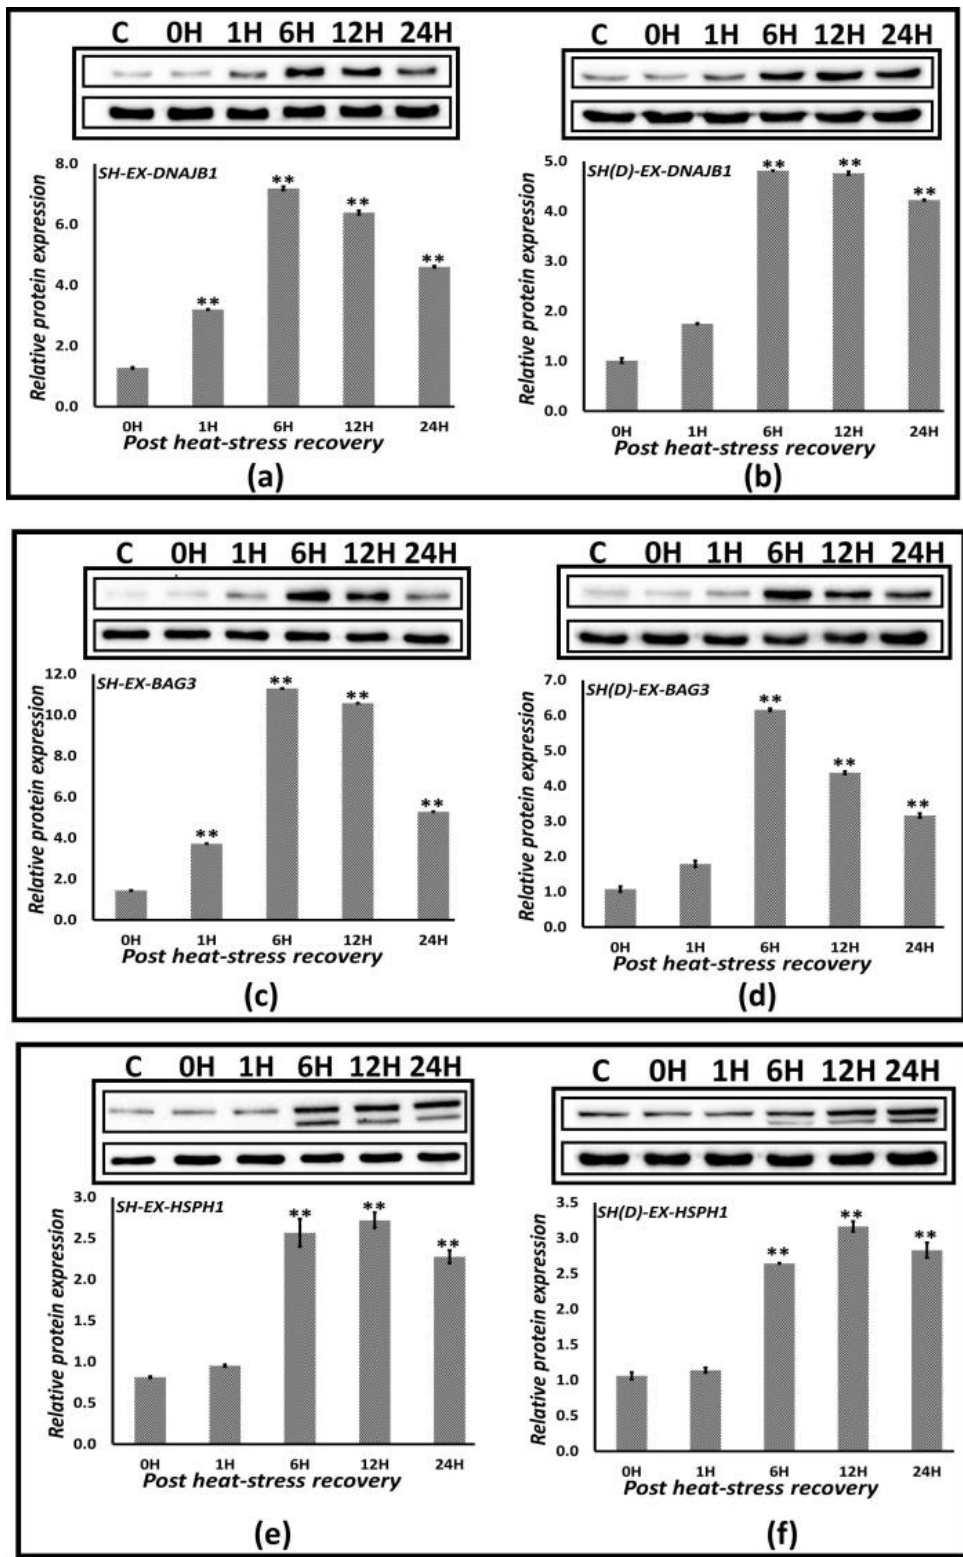
Figure 8. Protein profiling of the significantly Hsp70 co-expressing proteins. ( a , b ) DNAJB1, ( c , d ) BAG3, and ( e , f ) HSPH1 in SH-SY5Y [SH] and differentiated SH-SY5Y [SH(D)] cells. The bar graphs represent the quantification of the expression levels compared to the GAPDH control. The unpaired t-test calculated p values, ** p < 0.05.